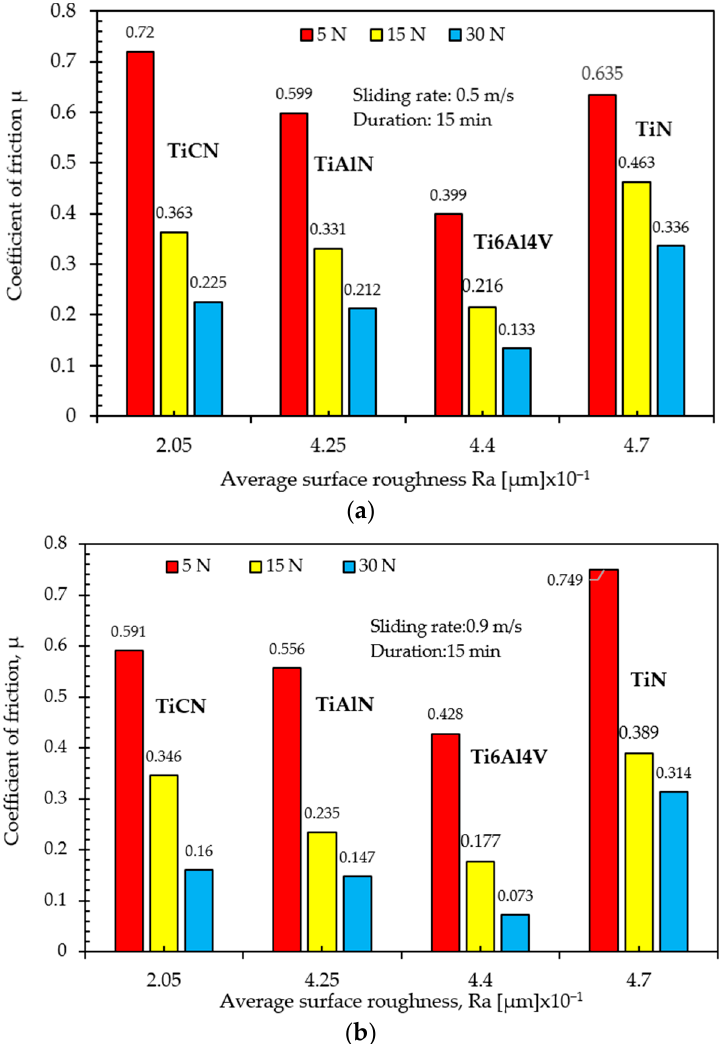
Figure 10. The variation in coefficient of friction with surface roughness. ( a ) 0.5 m/s sliding rate, ( b ) 0.9 m/s sliding rate.